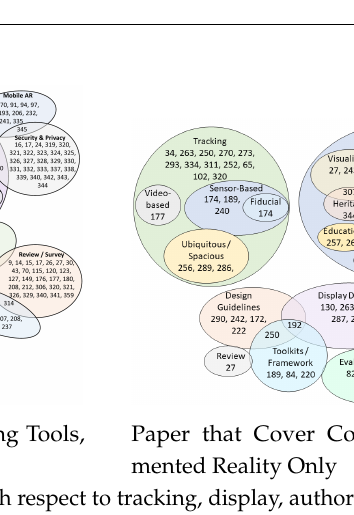
Figure 2. Classification of reviewed papers with respect to tracking, display, authoring tools, applica- tion, Collaborative and